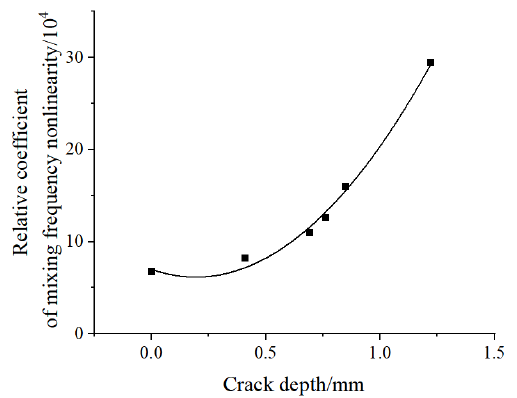
Figure 15. Relation between mixed-frequency factor and crack width.